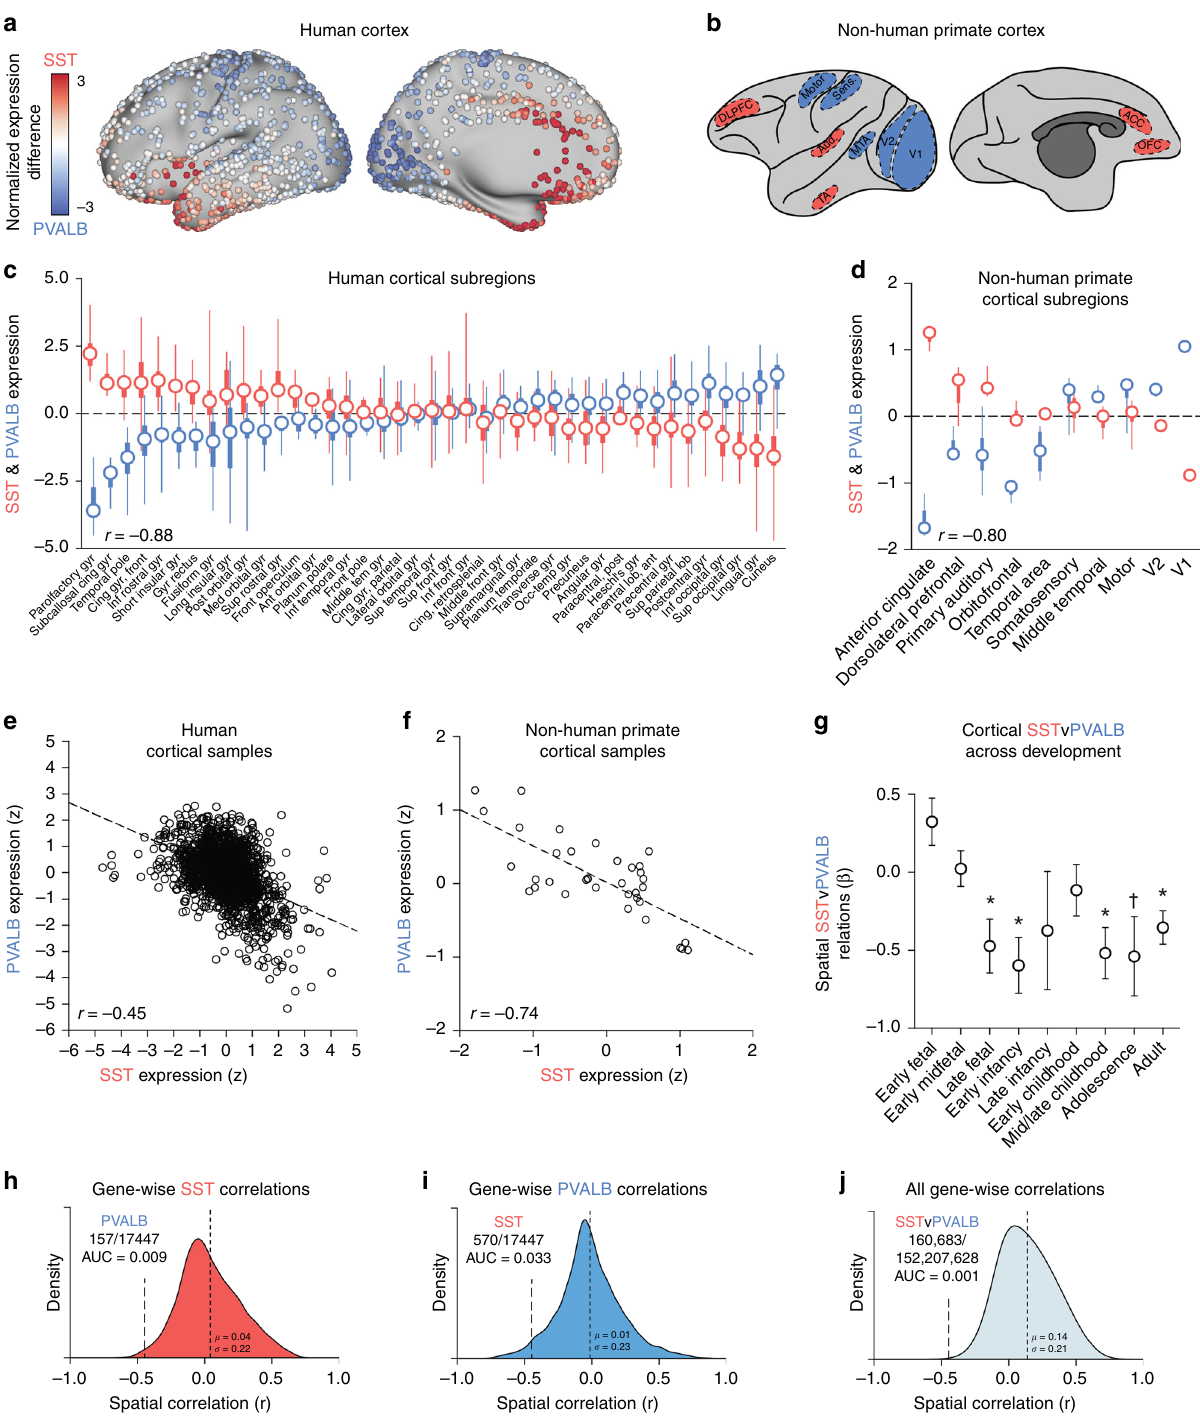
Fig. 1 Cortical expression of SST and PVALB are negatively correlated across species and developmental stages. a AHBA tissue samples mapped to the human cortical surface, and b an illustration of non-human primate tissue sample locations, colored by relative expression of SST (red) and PVALB (blue). Normalized expression difference re fl ects the sample-wise subtraction of z -transformed PVALB from SST . Relative SST – PVALB expression among anatomically de fi ned groups from the c AHBA ( n = 6 donors; n = 1683 samples; n = 41 regions) and d NIH Blueprint Non-Human Primate Atlas ( n = 4 donors; n = 182 samples; n = 10 regions); circles = median, thick lines = interquartile range, thin lines = min and max values. e Sample-wise negative correlation of SST and PVALB in human cortex ( r = − 0.45, p < 2.2e − 16; r s = − 0.40, p < 2.2e − 16) and f non-human primates ( r (34) = − 0.74, p = 2.2e − 7; r = − 0.60, p = 0.0001). g Correlation of cortical SST and PVALB across nine developmental stages using data from the Brainspan Atlas of the Developing s Human Brain ( n = 42 donors; n = 362 samples; n = 9 developmental stages). h – j The SST to PVALB correlation is at the left tail of the distribution of all gene-wise correlations to SST (AUC = 0.009) and to PVALB (AUC = 0.033), as well as all possible two-gene spatial correlations (AUC = 0.001). * p ≤ 0.05, uncorrected; † p ≤ 0.10; error bars = standard